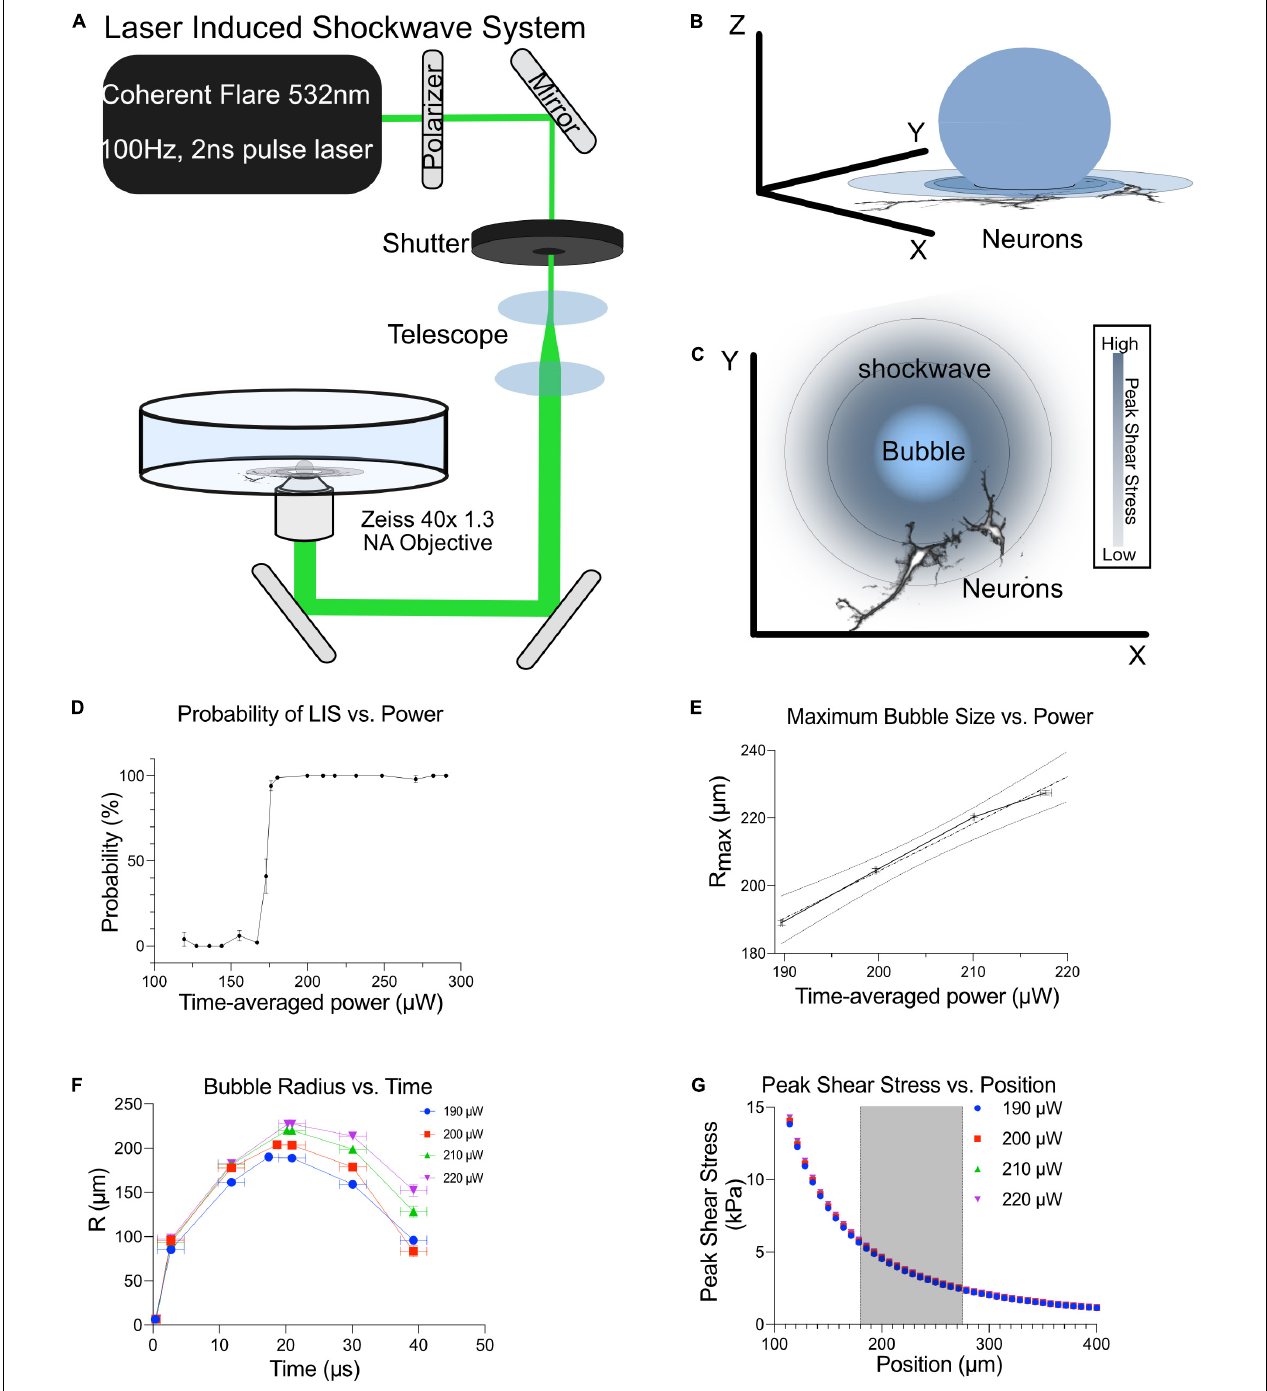
FIGURE 1 | Shockwave laser system. (A) A Coherent Flare 532 nm 100 Hz 2 ns Laser was passed through a polarizer to control output power. The beam was shuttered to permit the passage of 1–2 pulses when triggered. This beam was telescoped to expand the beam width to fill the back aperture of a 40x 1.3 NA oil objective. The broadened beam was then reflected onto a custom laser entry port that was placed underneath the objective. (B) Bubble expansion and shockwaves propagating through neurons. (C) Top view of bubble and shockwave (concentric rings) as it propagates away from the bubble. The shear intensity of the shockwave decreases as you get further from the bubble, depicted by the decrease in blue shading. (D) The probability of LIS vs. time-average power. (E) Maximum bubble size as a function of time-average power. Shockwave was detected with the use of a high-speed camera to visualize cavitation bubble dynamics. (F) The bubble radius vs. time at different time-average powers is shown. (G) Shear stress at different distances with respect to time-average power is shown. Cells were positioned at 180–275 µ m from the laser focus, shaded region.